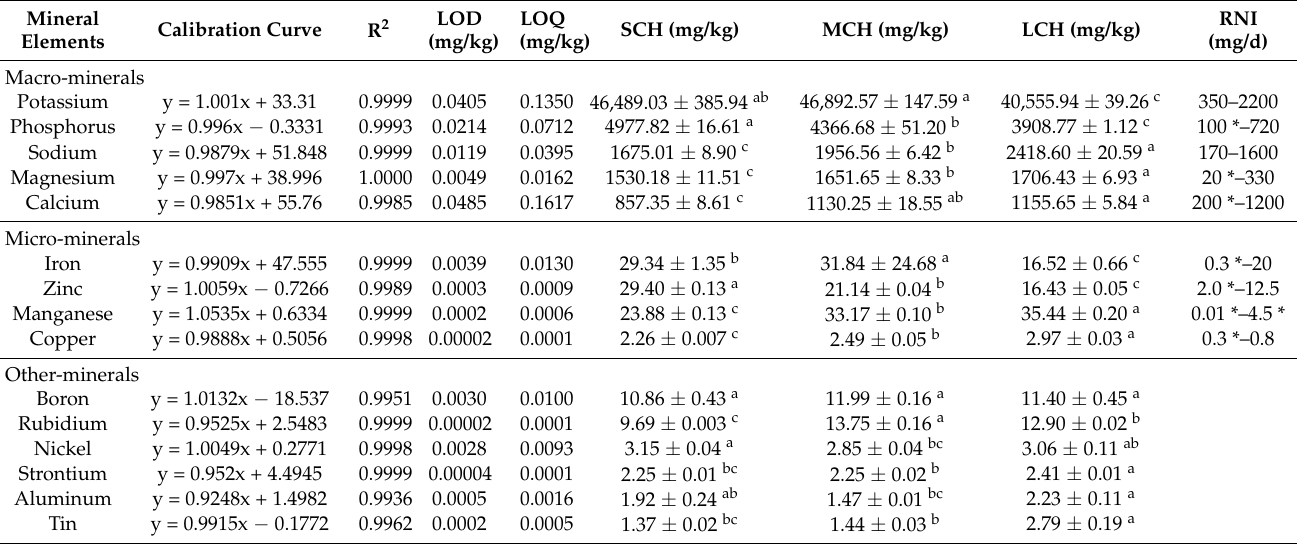
Table 4. Mineral elements of coconut haustorium 1